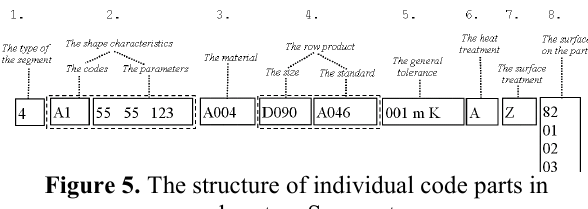
Figure 5. The structure of individual code parts in subsystem Segment